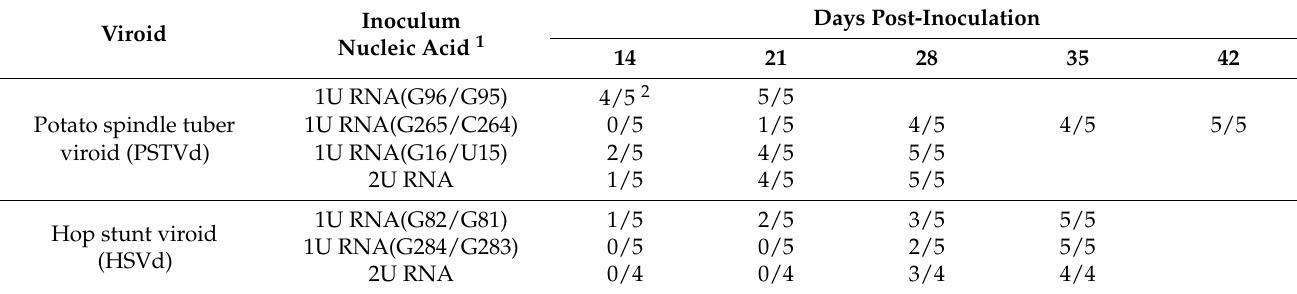
Table 2. Time-course of the infection rate of plants inoculated with monomeric or dimeric viroid RNA transcripts.